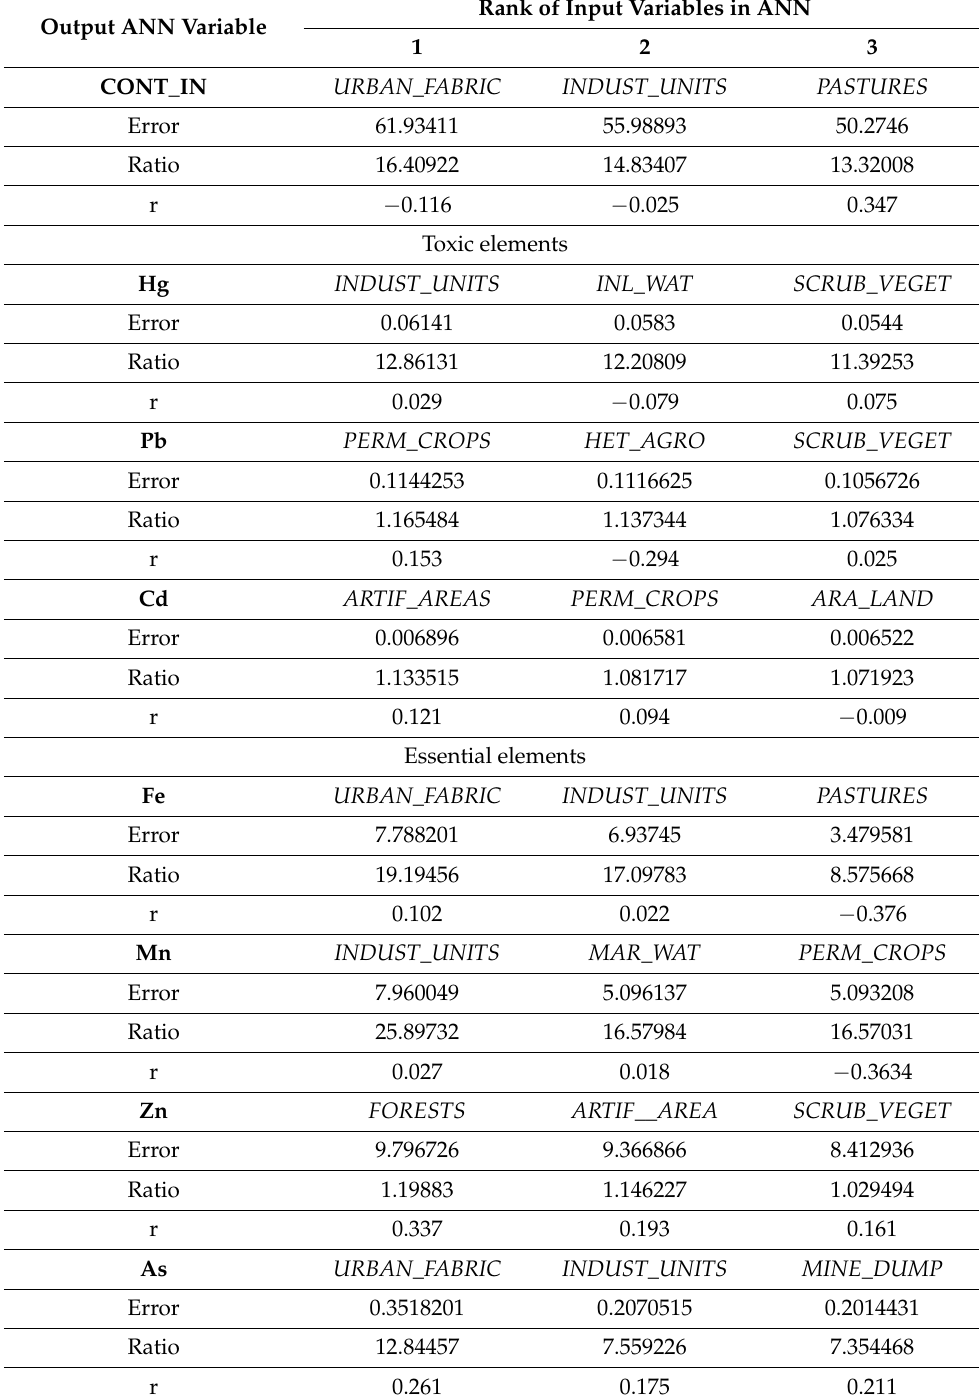
Table 4. The sensitivity analysis for the most important input variables (in italics) for the examined output variables (in bold) and Pearson correlation coefficient (r) for these